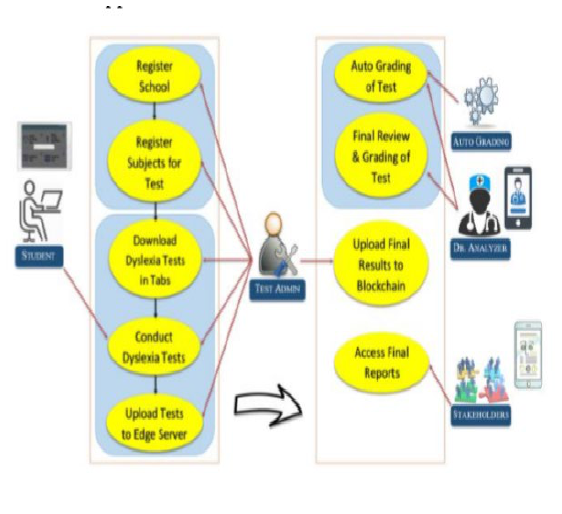
Figure 2. System design overview